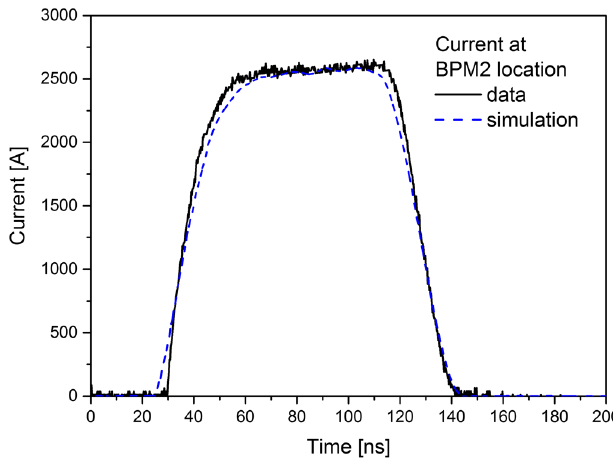
FIG. 6. Experimental and simulated currents at the BPM 2 location for the new 3.175 cm radius velvet cathode and a 201 A driving